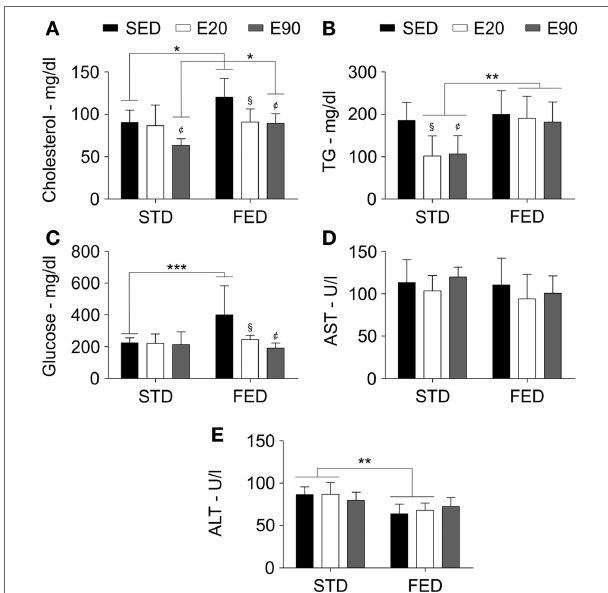
FigUre 5 | a fat-enriched diet and physical training alter serum biochemical markers . Standard biochemical analyses determined serum levels of cholesterol (a) , triglycerides [TG; (B) ], glucose (c) , aspartate aminotransferase [AST; (D) ], and alanine aminotransferase [ALT; (e) ]. Statistical Analysis I: ¢ p < 0.05 vs standard diet (STD)-SED or FED-SED; § p < 0.05 vs STD-SED or FED-SED. Statistical Analysis II: * p < 0.05, ** p < 0.01, *** p < 0.001. Data analysis: two-way ANOVA test (Bonferroni’s post hoc test). Reported values are the mean ± SD.